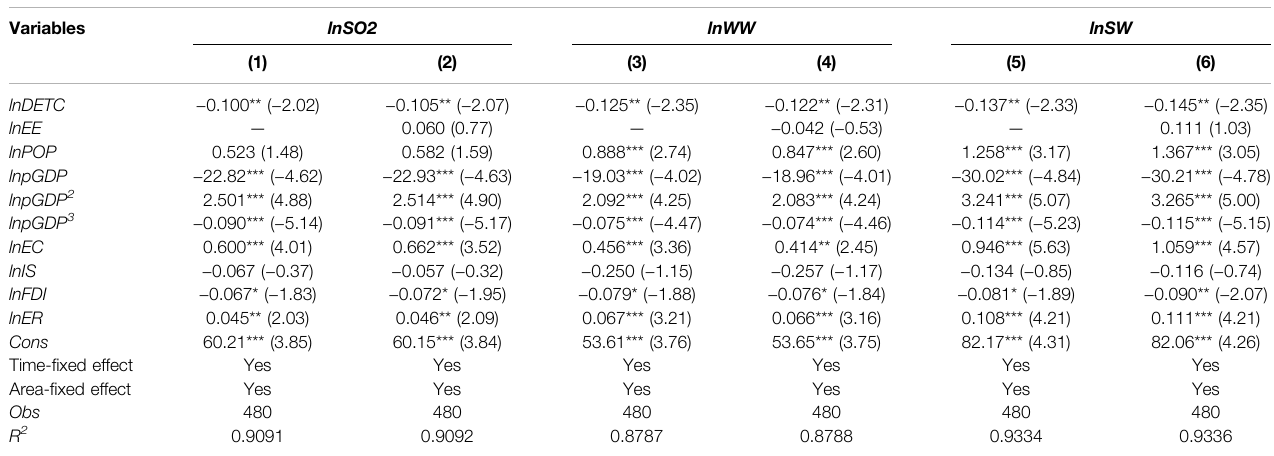
TABLE 5 | Robustness test with POLS